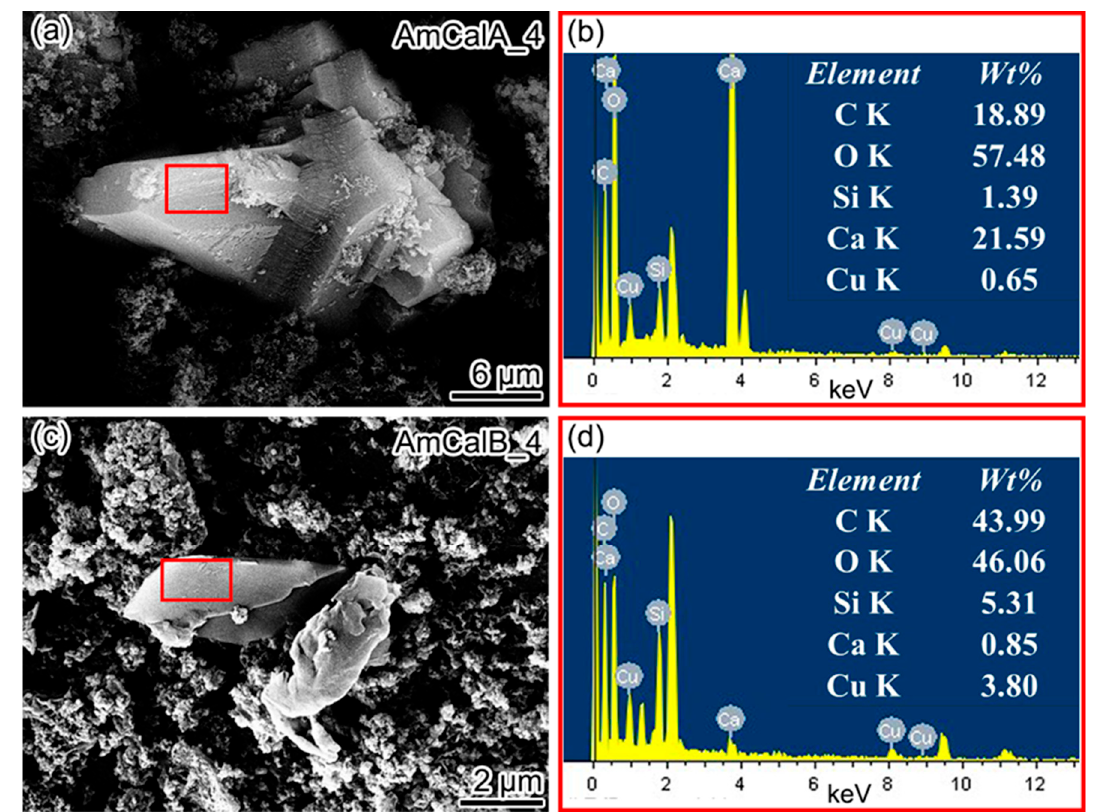
Figure 6. The SEM images of ComCal_1 ( a ), CryCal_1 ( b ), AmCalA _1 ( c ), and AmCalB_1 ( d ).